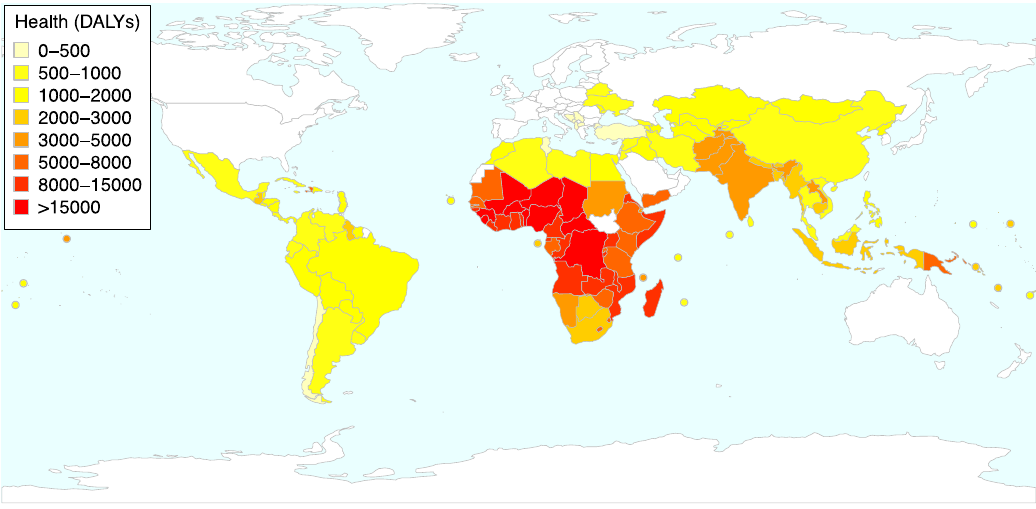
Figure 1. This figure shows overall impact of the indicators selected to construct the health index used as a measure to capture the sector’s climate sensitivity. The map shows the average lost DALYs over the six years included in the study lost due to the causes included in the index. Data source for all underlying variables: IHME